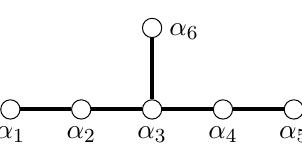
Figure 3 . Our convention for the labeling of the simple roots of E 6